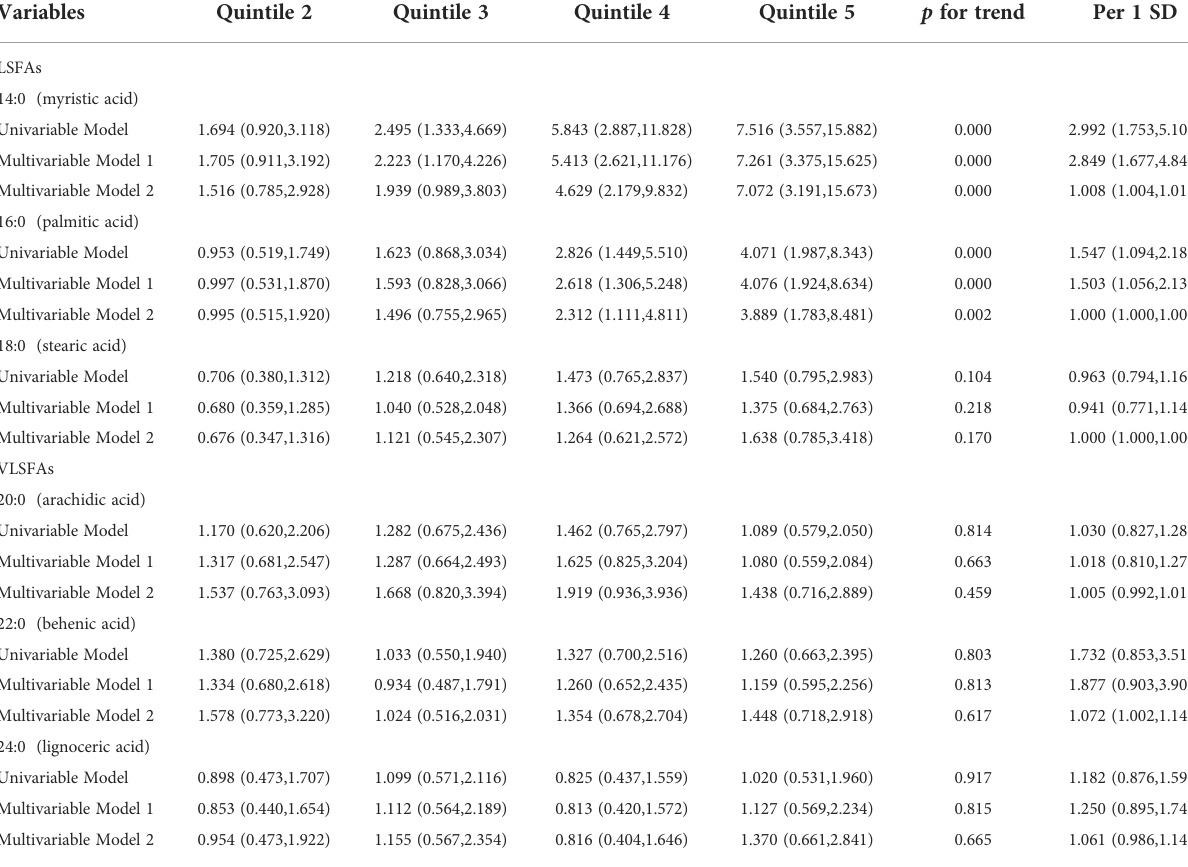
TABLE 2 Odds ratios (and 95% CIs) for nonalcoholic fatty liver disease by quintile of saturated fatty acids.